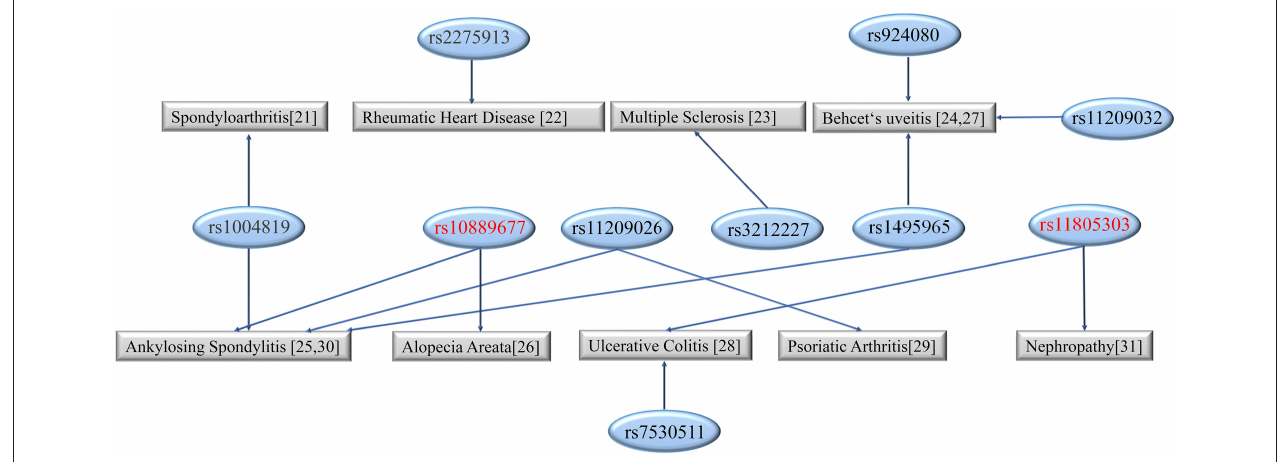
FIGURE 3 | The diseases linked to different sites of IL-23R . The SNPs studied in the present study are marked in